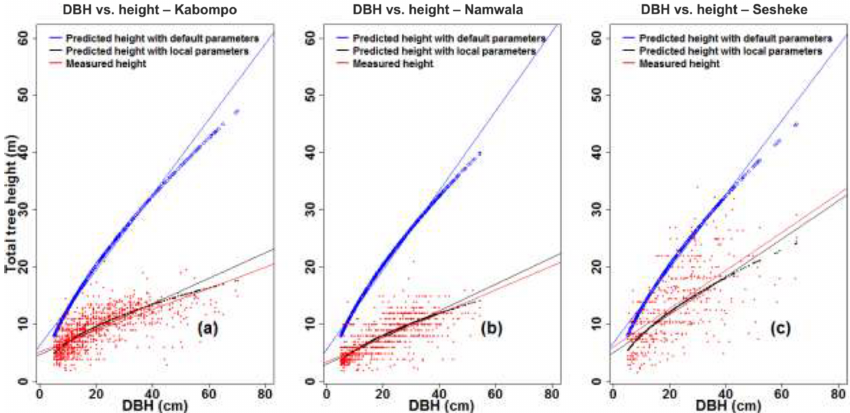
Figure 4. Measured and predicted total tree height, plotted against DBH at Kabompo (a) , Namwala (b) , and Sesheke (c) .